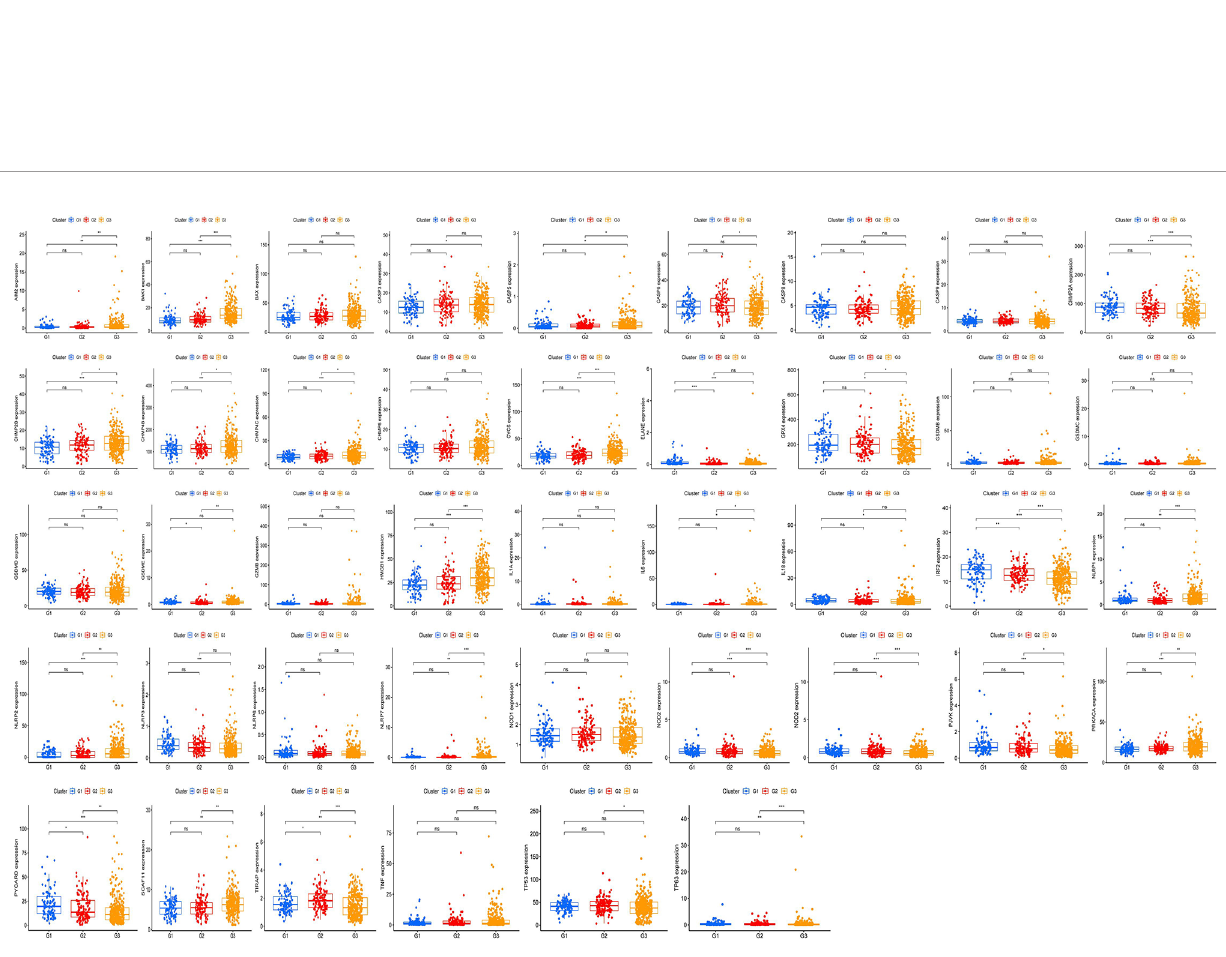
FIGURE 4 | Immune landscape of uterine corpus endometrial carcinoma (UCEC). (A) The fraction of 22 types of immune cells in UCEC patients and normal cases. (B) The correlation of 22 types of immune cells in UCEC samples. (C) The correlation of 42 UCEC-associated pyroptosis-related gene expression and the abundance of immune cell in fi ltration. P-values are shown as: *p < 0.05; **p < 0.01.